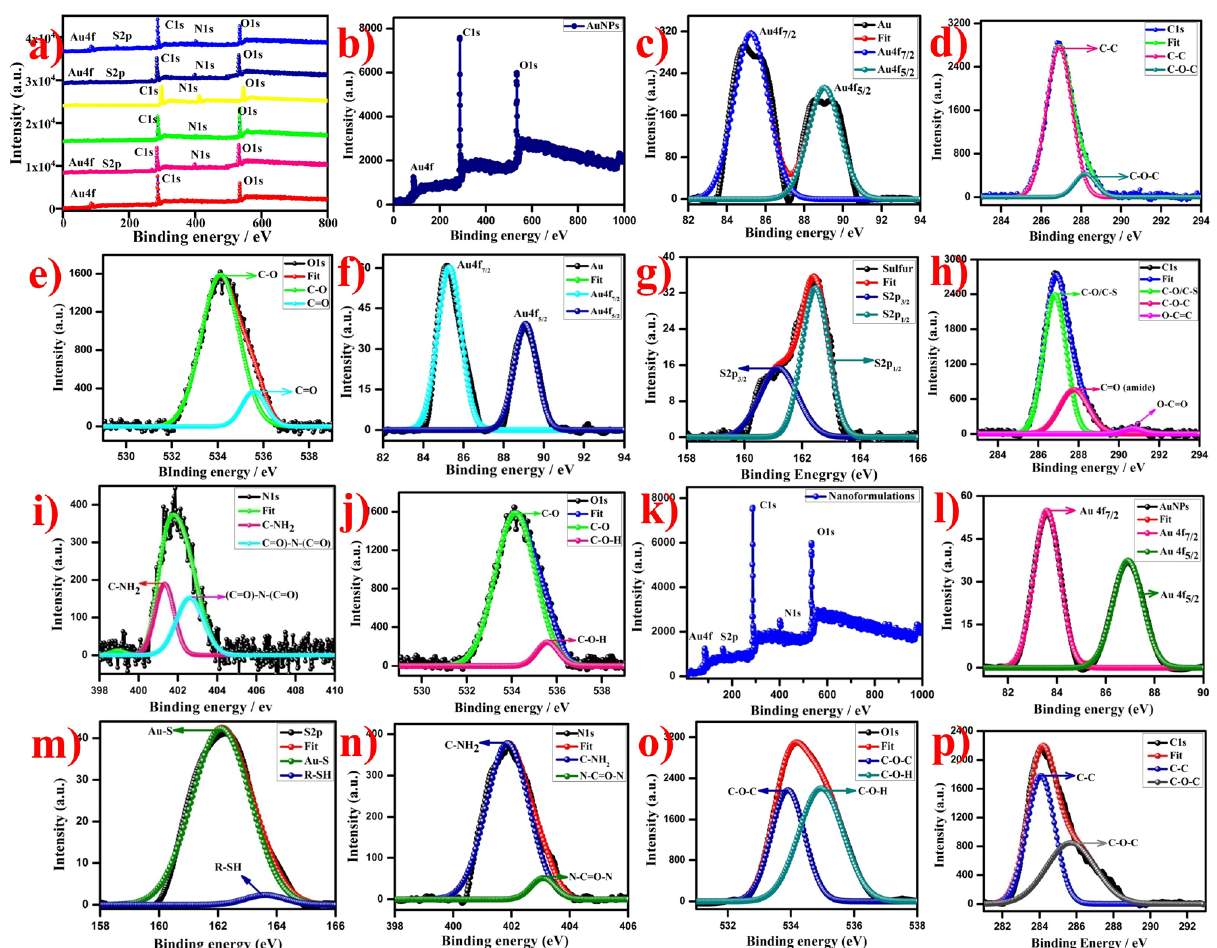
Figure 7. XPS spectra of gold nanoformulations, ( a ) overall survey spectra, ( b – d ) Survey spectrum of AuNPs and corresponding high resolution spectra as follows ( c ) Au4 f 5/2 and Au4 f 7/2, ( d ) C1 s , ( e ) O1 s , ( f – j ) high resolution spectra of PEG functionalized AuNPs ( f ) Au4 f , ( g ) S2 p , ( h ) C1 s , ( i ) N1 s and ( j ) O1 s and ( k – p ) Survey spectrum of gold based nanoformulations and corresponding high resolution spectra ( k ) survey spectrum, ( l